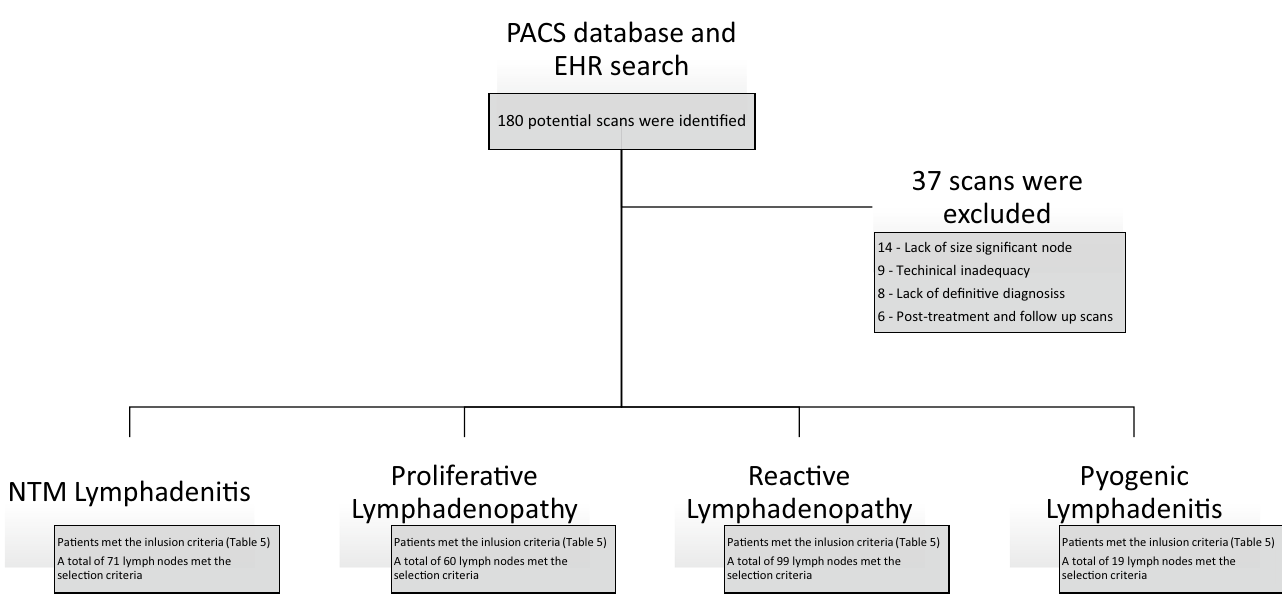
Figure 3. Study subjects—figure identifies the breakdown of the patient diagnosis. Specific selection criteria are described in Table